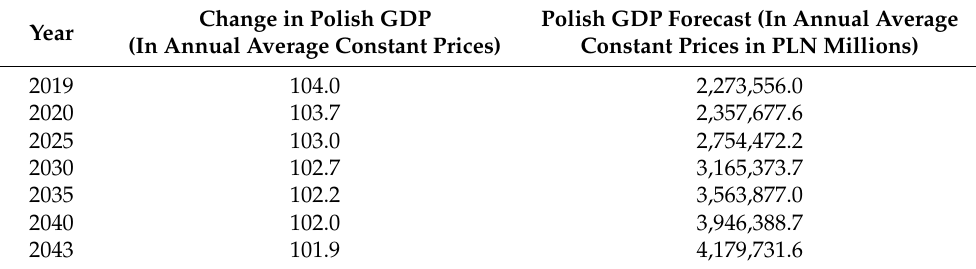
Table A3. GDP growth forecast for 2019–2043 (selected years only) expressed in GDP growth indicators (calculated year-on-year, previous year = 100) and in million PLN in constant annual average